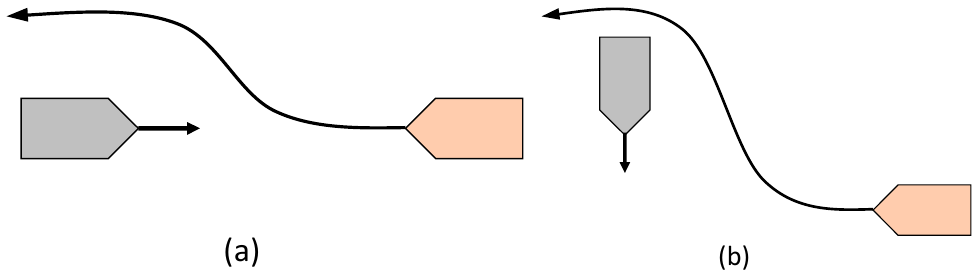
Figure 3. ( a ) A head-on situation between two ships; ( b ) a crossing situation between two ships (give-way); the orange ship must give way to the crossing ship on its starboard side.